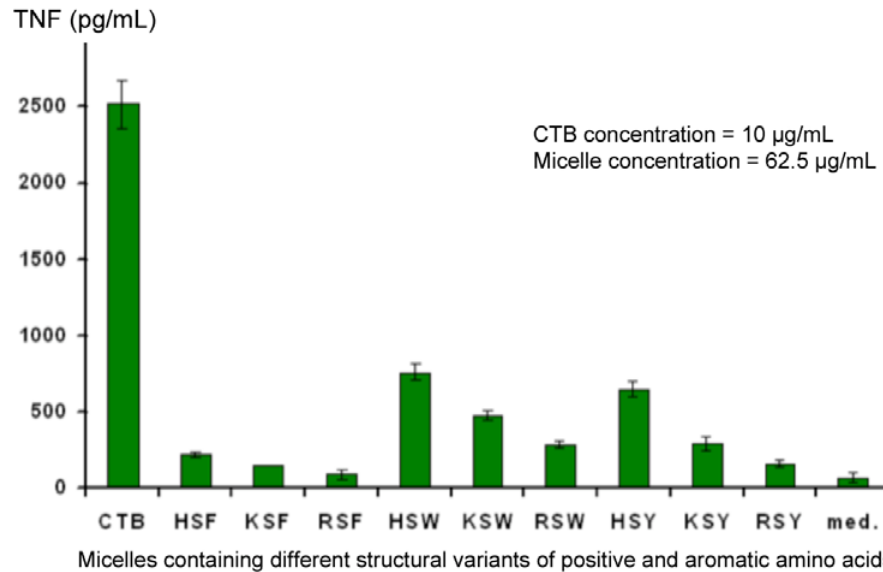
Figure 9. Identification of the optimal combination of amino acids required to down-regulate secretion of TNF from CTB-stimulated J774A.1